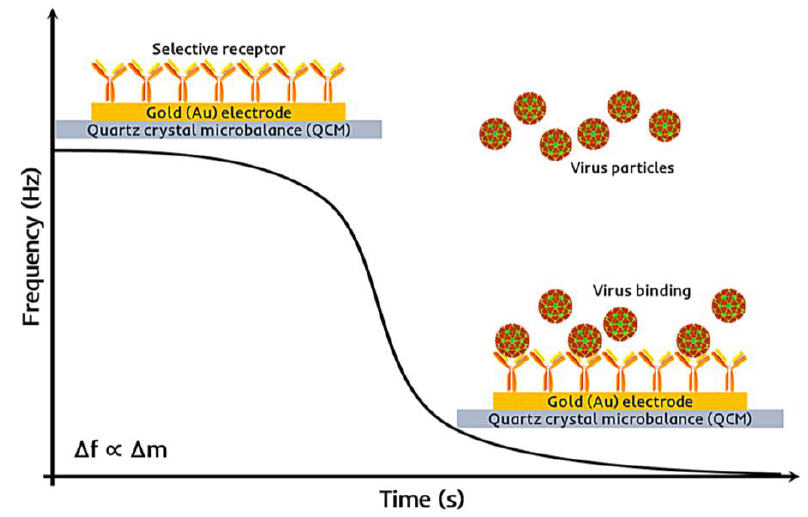
Figure 1. The principle of a QCM-based gravimetric virus sensor. The change in mass in response to virus binding with the selective receptor is detected as a change in frequency of QCM transducer.